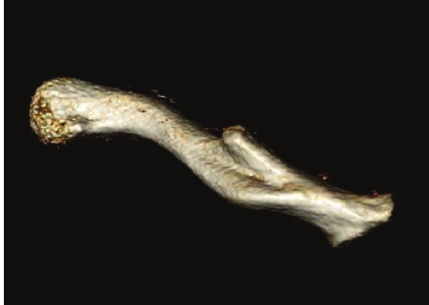
Figure 2: 3D reconstruction showing posterior view of clavicle.